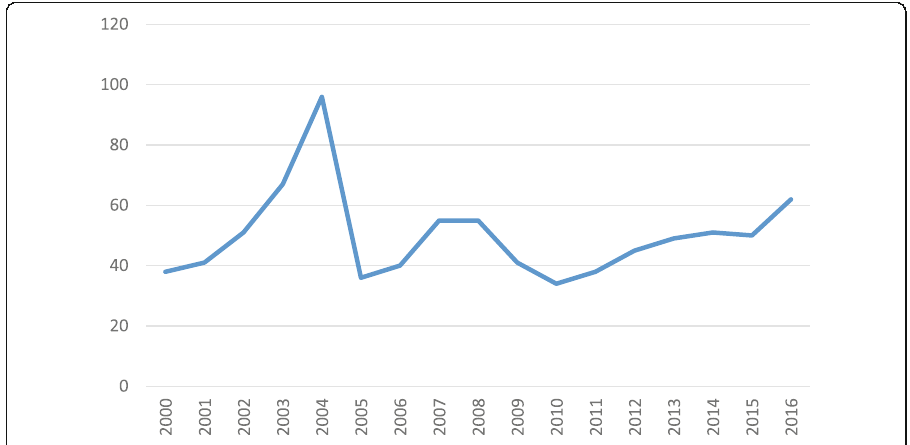
(ii) firms that were never certified (represented by the lighter solid arrows). Within the first category are firms that are “ certified ” (represented by darker solid arrows) and “ de- certified ” as of 2006 or in another years after that (represented by the lighter broken ar- rows). In addition, firms that were certified at least once have different years of initial adoption, and this imply varying rates of initial adoption.